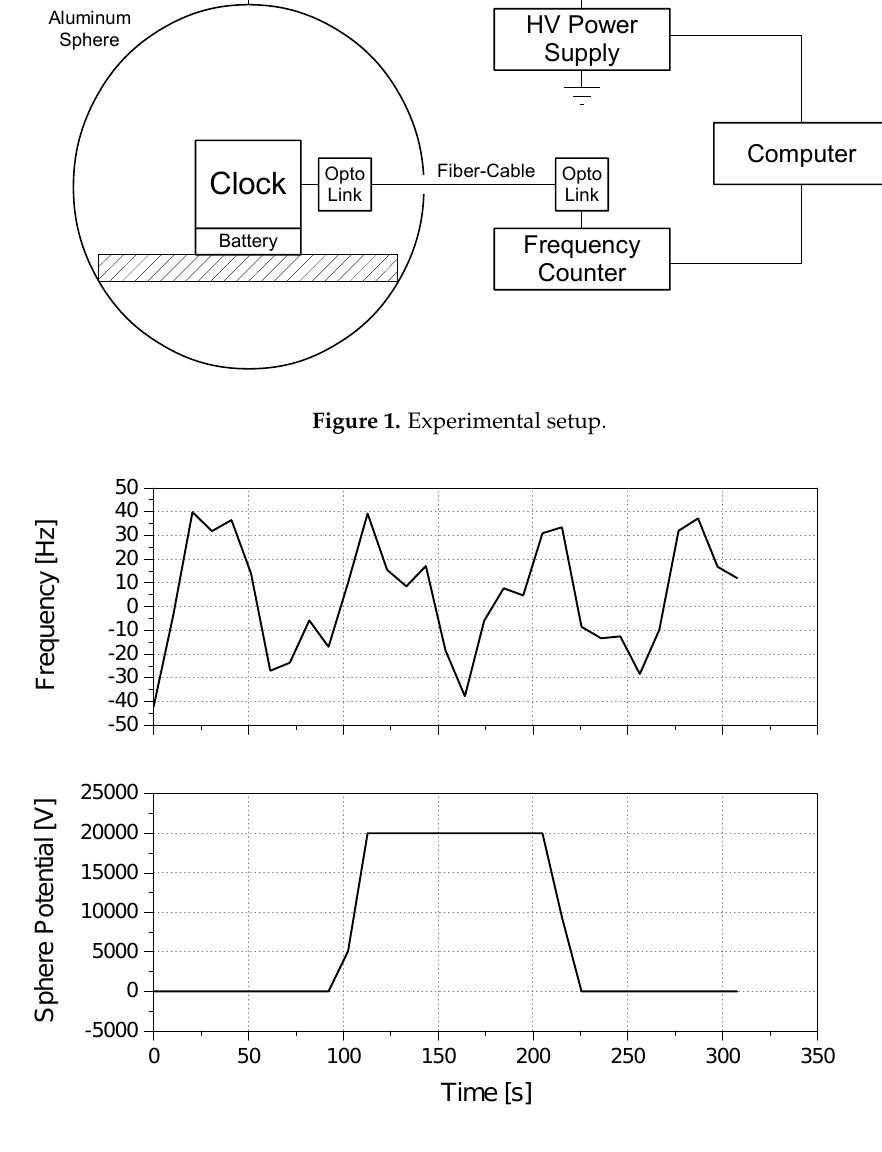
Figure 2. Example of the frequency change during one